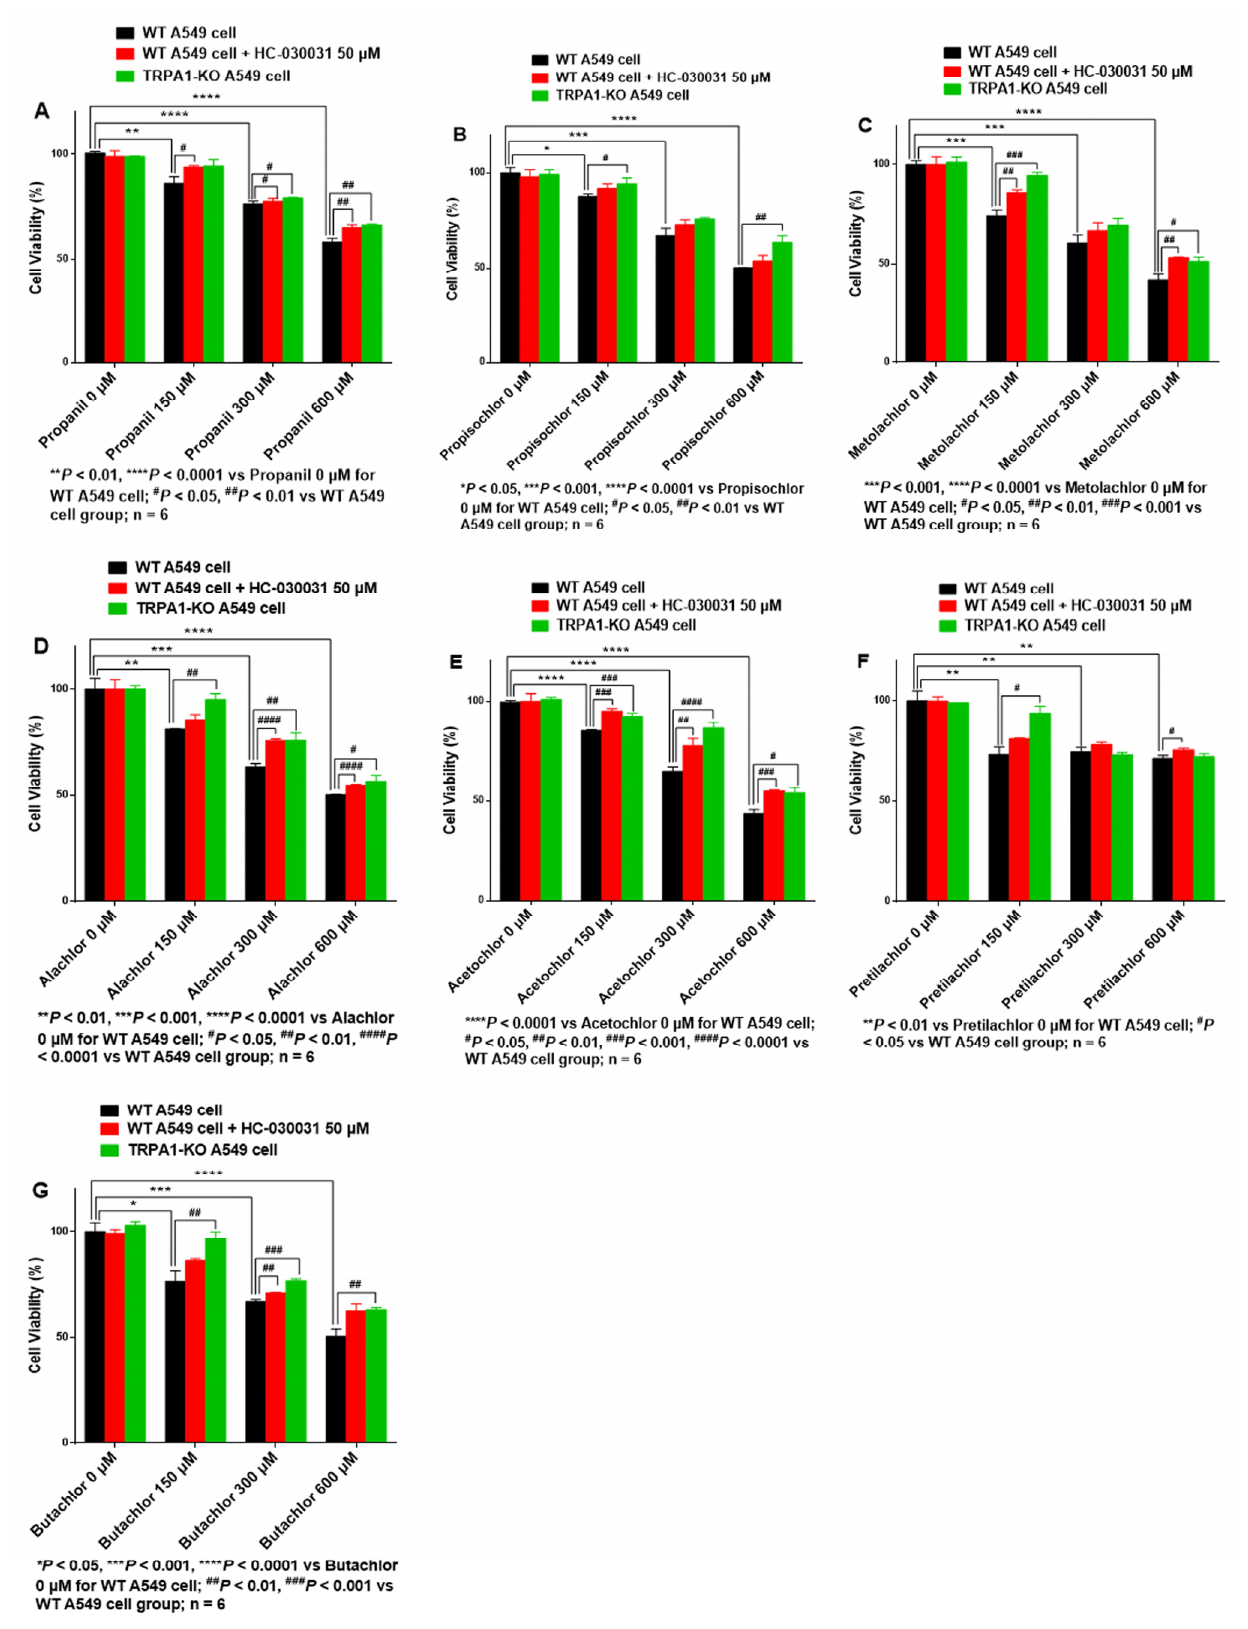
Figure 2. HC-030031 intervention or TRPA1 -KO increases cell viability of AHs toward A549 cells. ( A ) Propanil, ( B ) Propisochlor, ( C ) Metolachlor, ( D ) Alachlor, ( E ) Acetochlor, ( F ) Pretilachlor, ( G ) Butachlor.